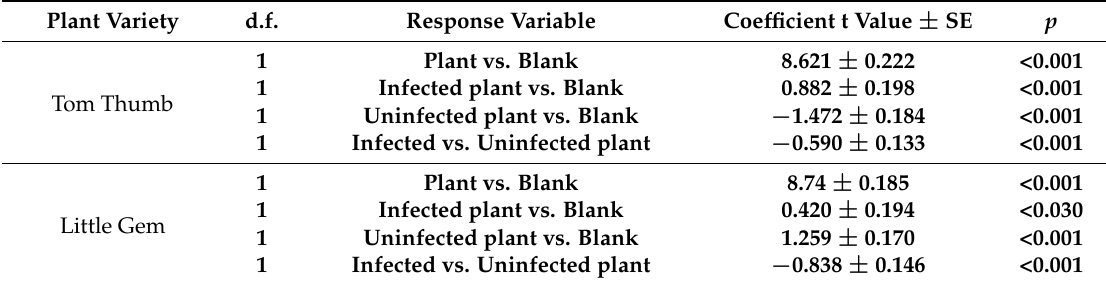
Table 6. Summary of effects of asymptomatic B. cinerea infection status and plant variety on parasitoid host preference behavior with aphids reared on two lettuce varieties. N = 30 for each treatment. Significant values are in